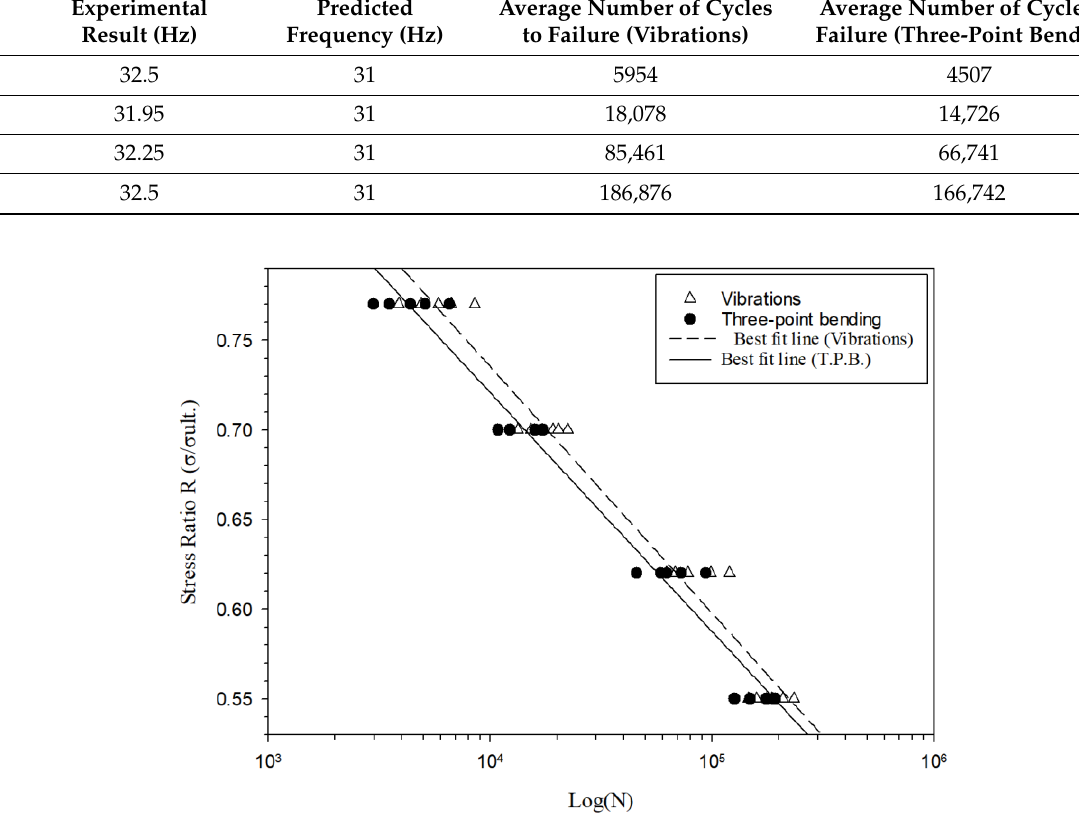
point bending test and vibration test.